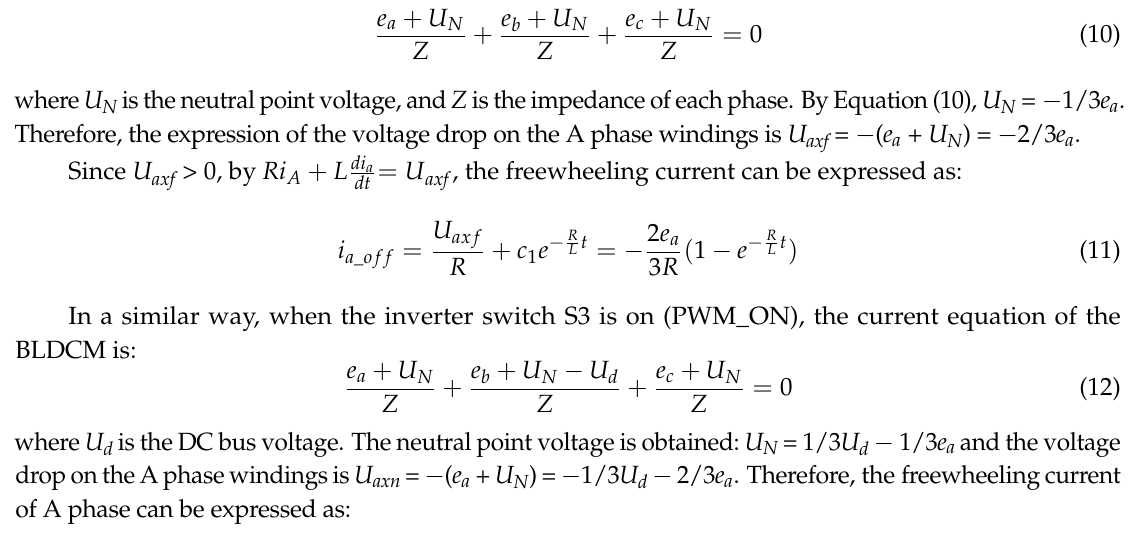
Figure 11. The freewheeling circuit in the π -to-7/6 π non-conduction intervals of A phase.